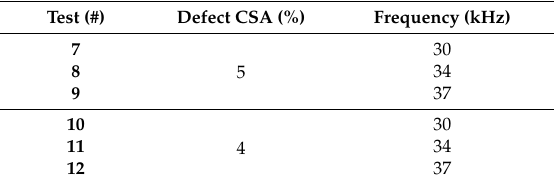
Table 2. Summary of the second set of tests conditions (second